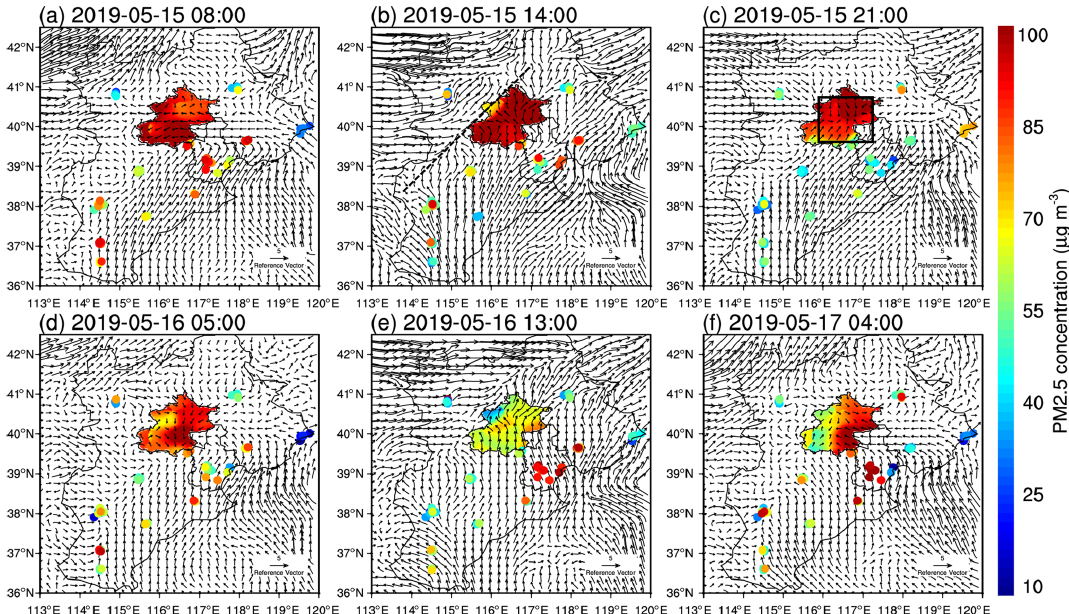
Figure 9. The surface winds (vectors; units: ms − 1 ) in the NCP and PM 2 . 5 concentration at the Beijing (shaded; units: 10 − 1 µgm − 3 ), Hebei, and Tianjin monitoring sites (scatter; units: 10 − 1 µgm − 3 ) of different times (local time) for type W. The dashed line represents the convergence belt. The rectangle represents the convergent